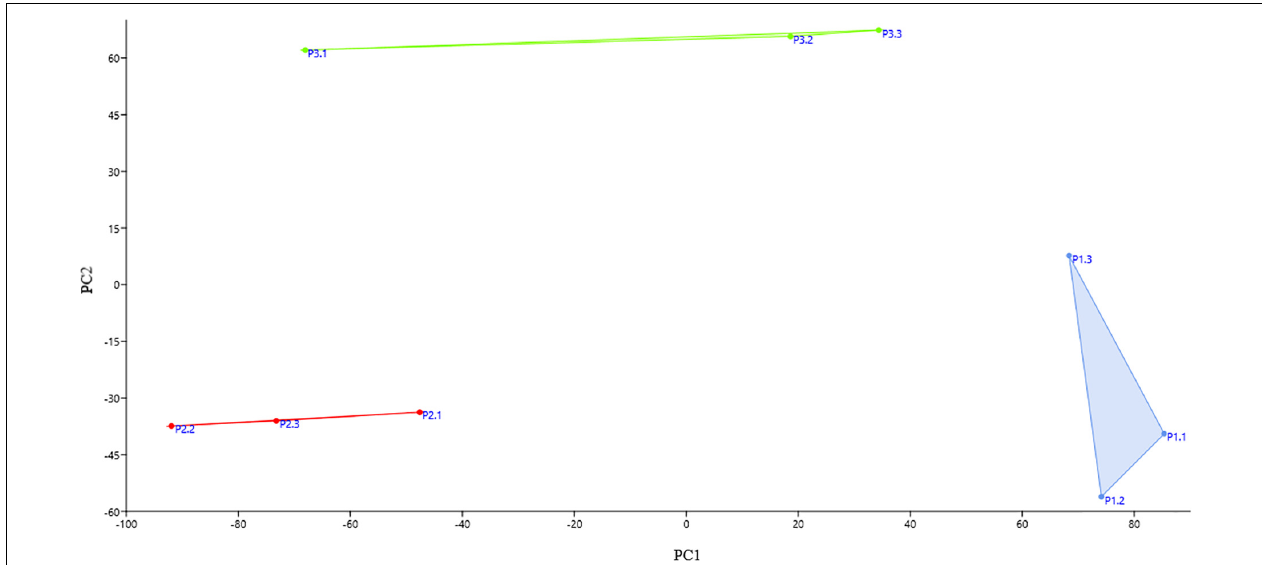
FIGURE 2 | Principal component analysis (PCA) score plot of each replicate at each collection site. The replicates of the same site group together and each site’s grouping was different from the others among the three sampling sites. Blue: the replicates of site P1; red: the replicates of site P2; and green: the replicates of site